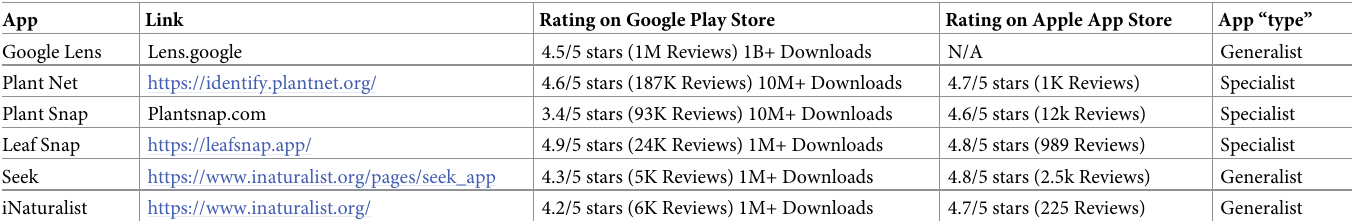
Table 1. Plant identification applications selected for evaluation for this study with ratings and approximate number of downloads as of November